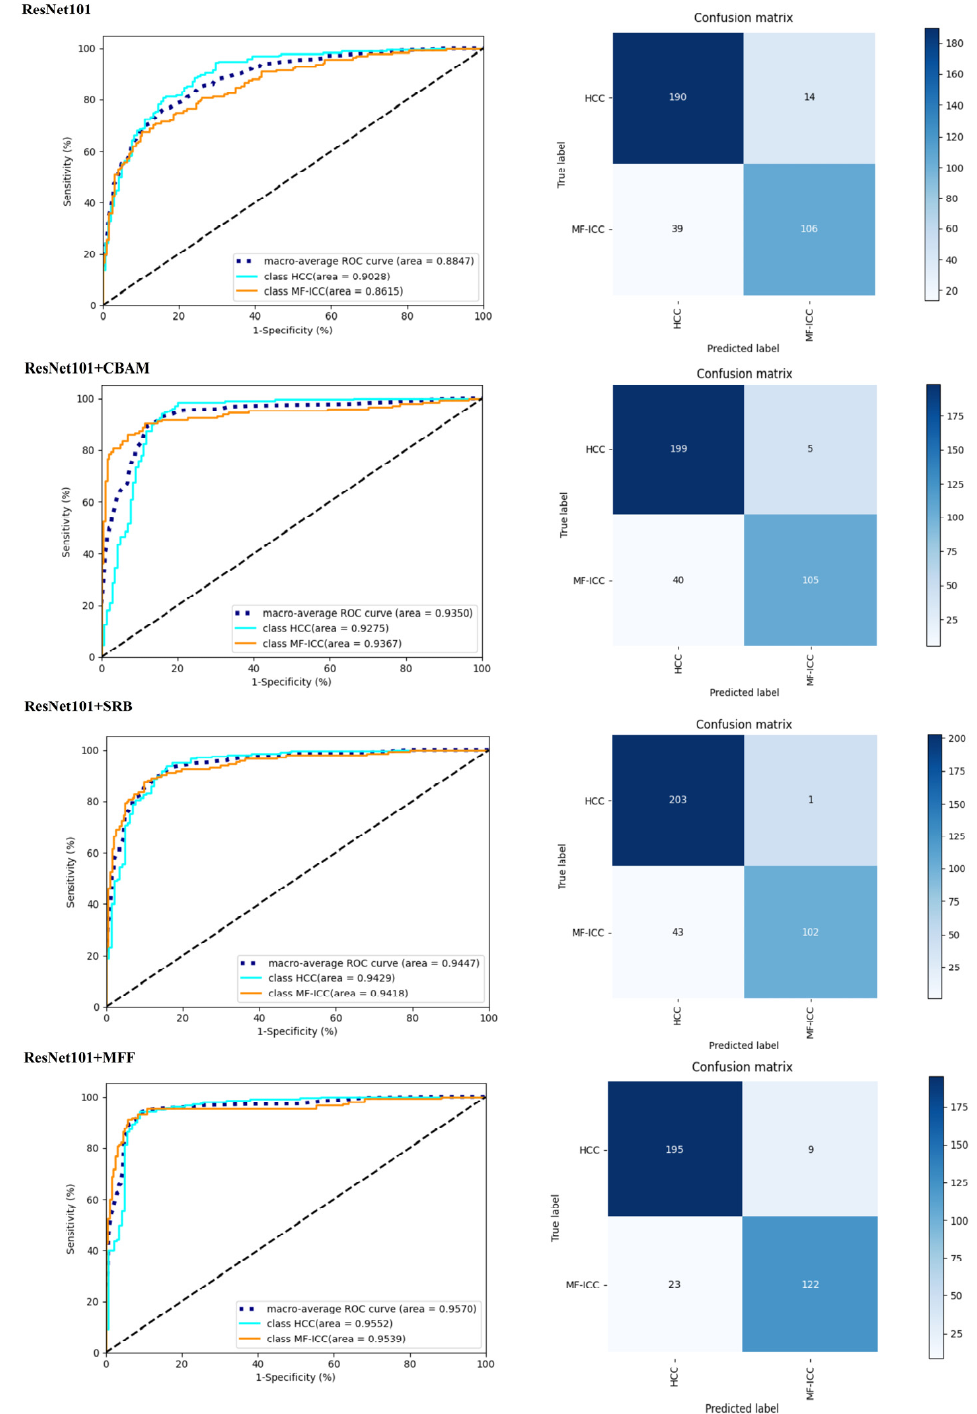
Figure 8. The left is the receiver operating characteristic curve (ROC) and the right is the confusion matrix related to the ablation experiment (the blue line is the ROC of HCC, the orange line is the ROC of MF-ICC, and the dashed line is the overall ROC).